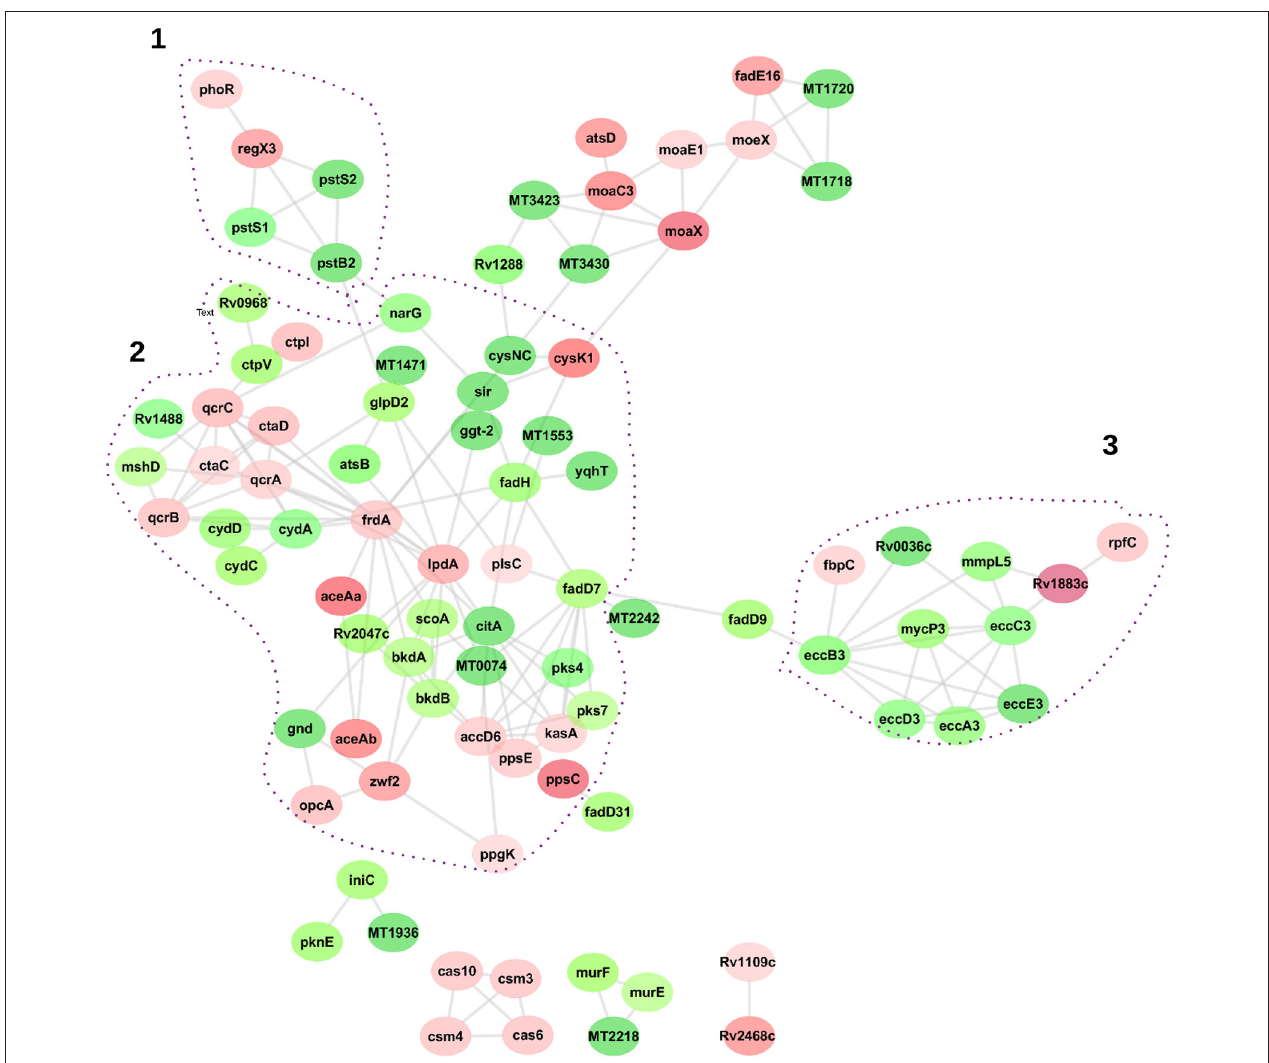
FIGURE 6 | Network interaction analysis of differentially abundant proteins related to M. tuberculosis lineages 7 and 4. Graphical representation of the interaction was generated by the Cytoscape software version 3.4. Proteins are represented as nodes, and the biological relationship between two nodes is represented as an edge (line). The intensity of the node color indicates the increased (red) or decreased (green) abundance according to fold changes. Dot-lined circles indicate sub-networks of proteins linked to specific KEGG